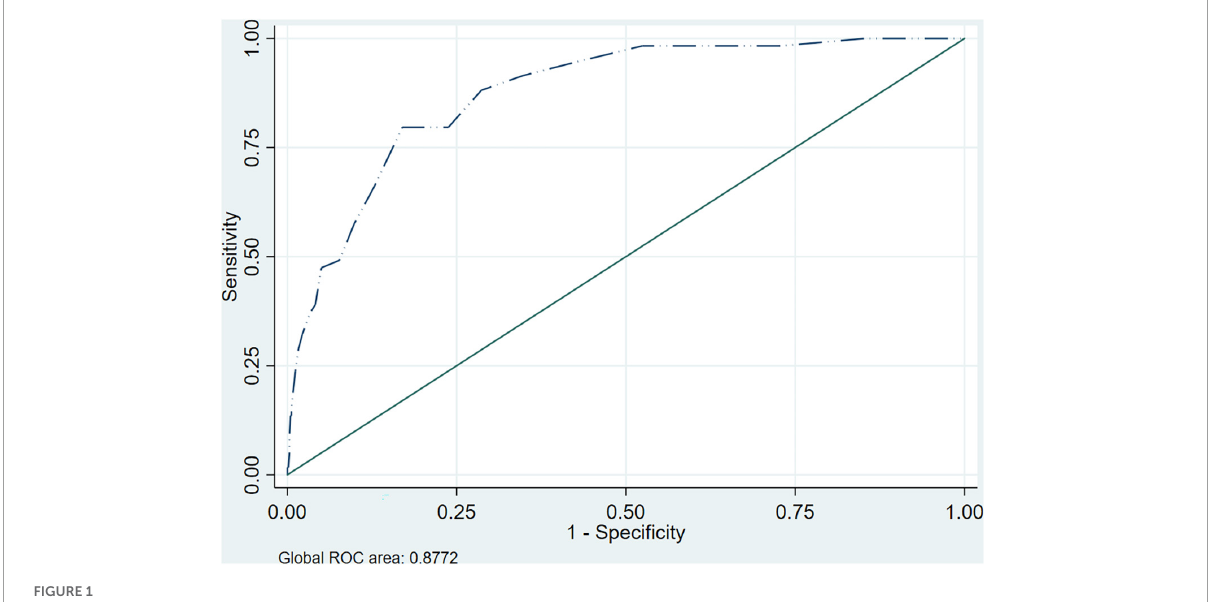
FIGURE1 ROC curve and AUC HSCL-10 vs.